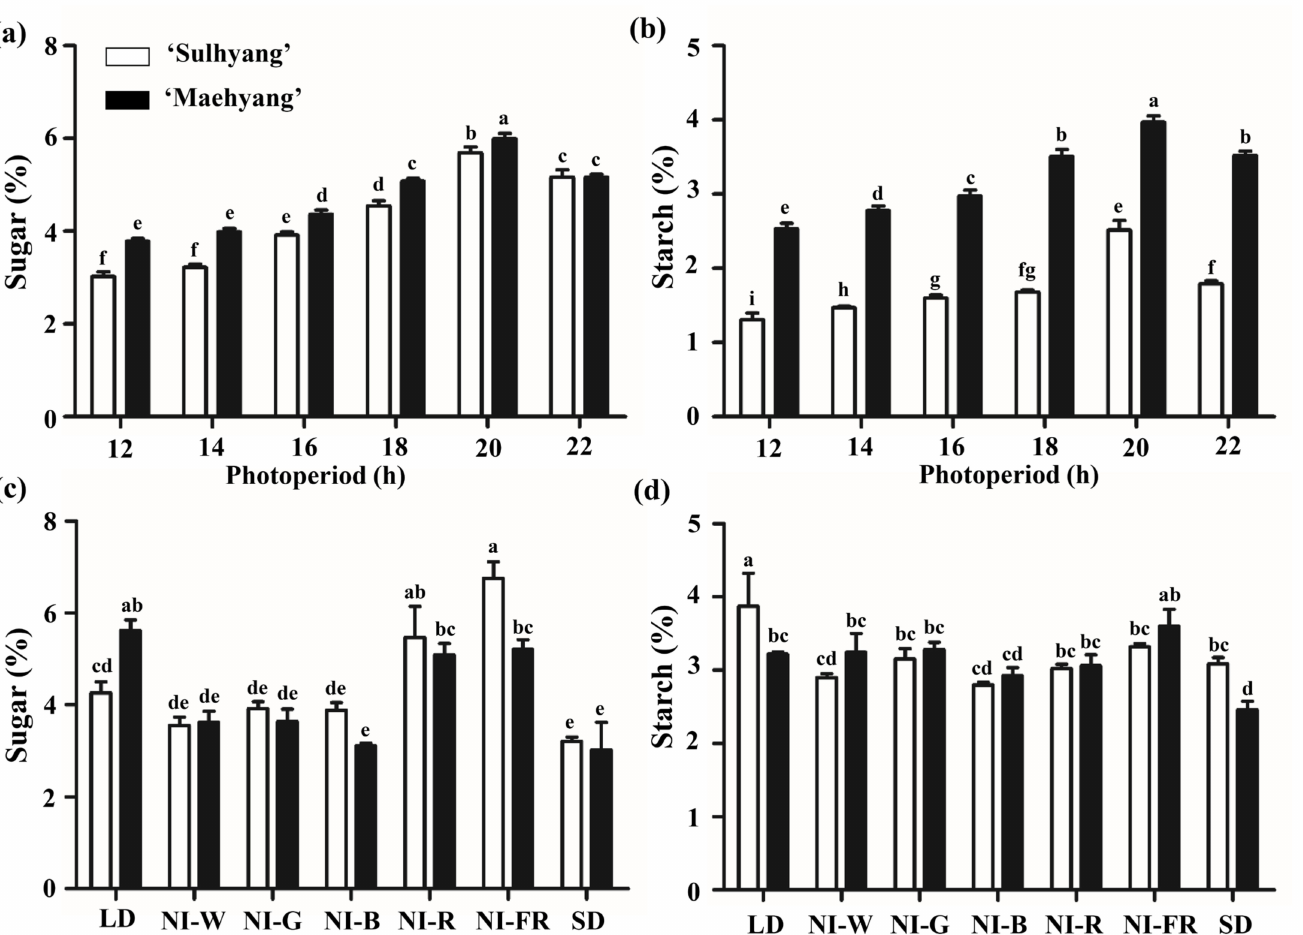
Figure 5. Contents of sugar and starch as affected by photoperiod ( a , b ) and quality of night interruption (NI) light ( c , d ): LD, long day; SD, short day; W, white; G, green; B, blue; R, red; and FR, far-red. Lowercase letters indicate significant difference according to the Duncan’s multiple range test at a 0.05 level. Vertical bars indicate standard